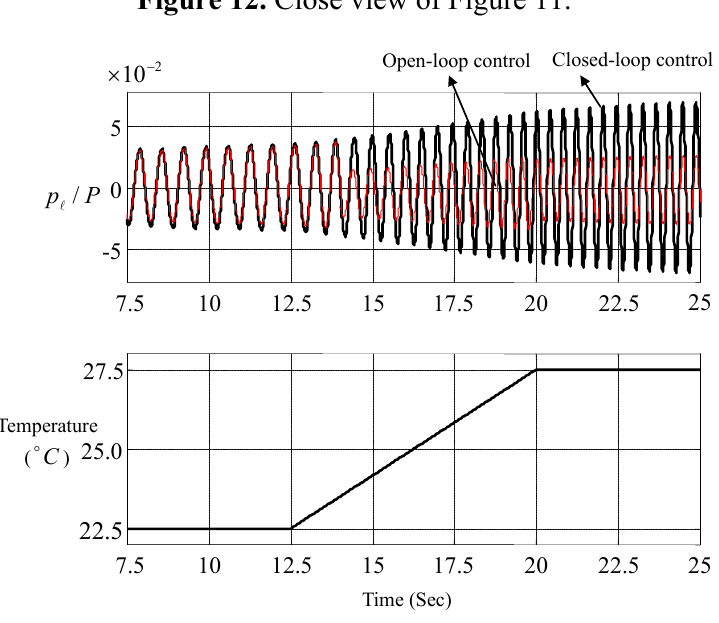
Figure 12. Close view of Figure 11.